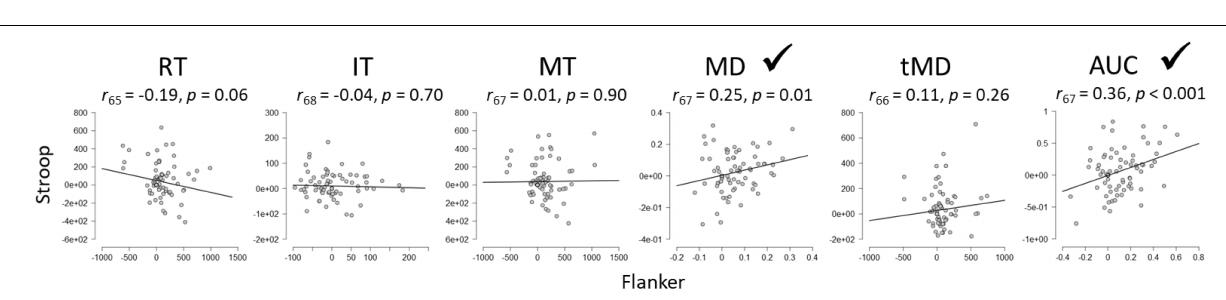
FIGURE 6 | Between-task reliabilities of the SCE for Flanker and Stroop tasks. RT, Reaction Time; IT, Initiation Time; MT, Movement Time; MD, Maximum Deviation; tMD, Time to Maximum Deviation; AUC, Area Under the Curve. Checkmarks indicate significant correlations ( p <